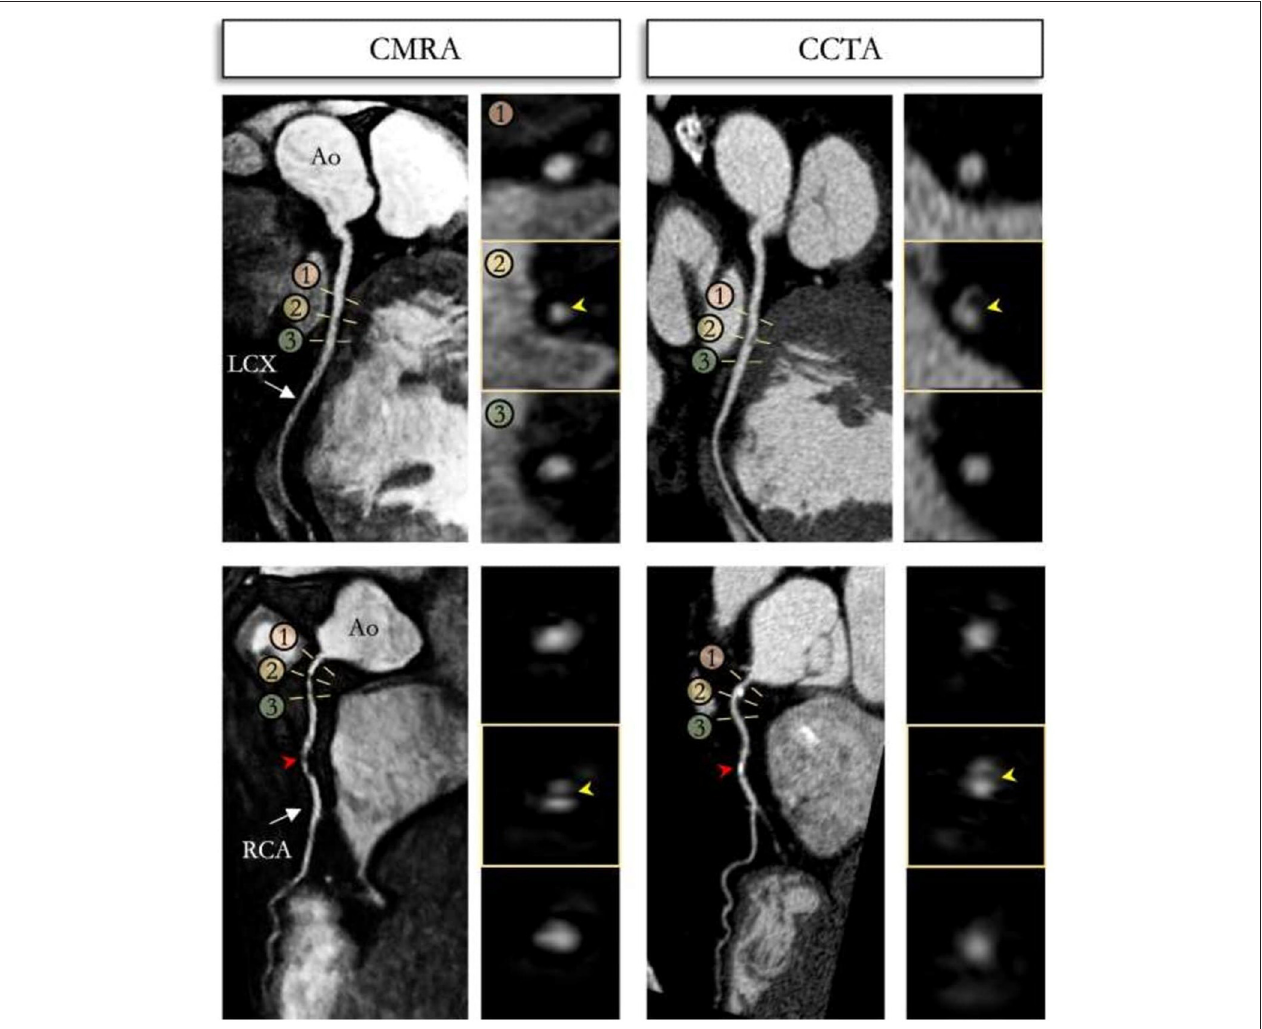
FIGURE 9 | Reformatted non-contrast whole-heart sub-millimeter isotropic CMRA (left) and CCTA (right) images along the LCX (top) and RCA (bottom) are shown for a 54 year-old male patient. The CMRA dataset was acquired in 9min with 100% scan efficiency (heart rate of 57 bpm). The CCTA images demonstrate mild (25–49%) disease with a calcified plaque within the proximal RCA and severe disease (70–90%) with a partially calcified plaque in the mid-segment of RCA (red arrows), and minimal (0–24%) disease with calcified plaque in the mid-segment of the LCX. Luminal narrowing is seen on the cross-sectional views at the sites of coronary plaque on the CMRA images (yellow arrows). LAD, left anterior descending artery; RCA, right coronary artery; LCX, left circumflex artery; Ao, aorta. Adapted with permission from Bustin et al. (65).